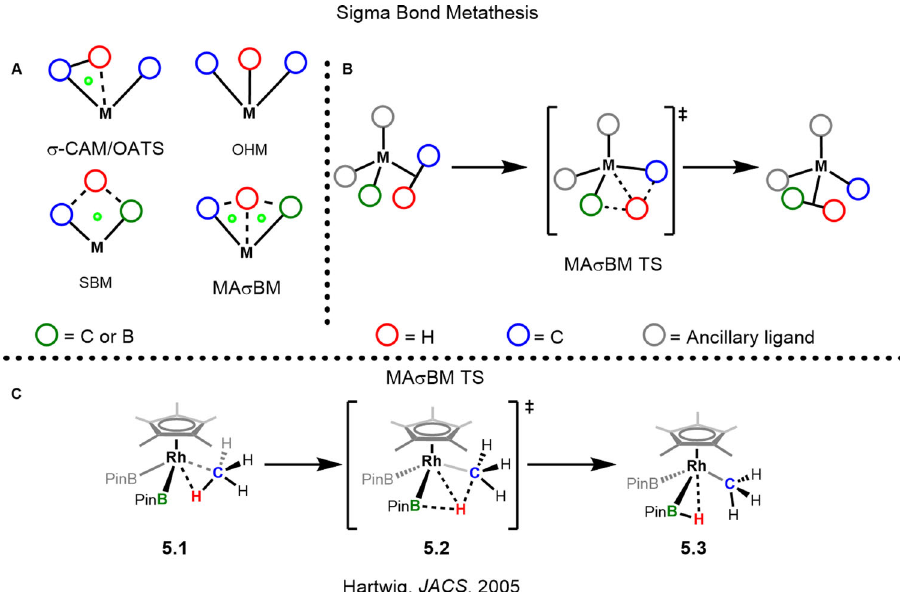
Fig. 6 Sigma bond metathesis mechanisms. A Transition states encountered during the different sigma bond metathesis mechanisms; green dots represent the ring critical points of the interaction which show the point of minimum electron density in the interaction 76 . B Simpli fi ed reaction mechanism for MA σ BM reaction. C Hartwig ’ s alkane borylation reaction date: the borylation of unbranched alkanes which have a multi- tude of uses, including Suzuki cross-couplings 77,84 .